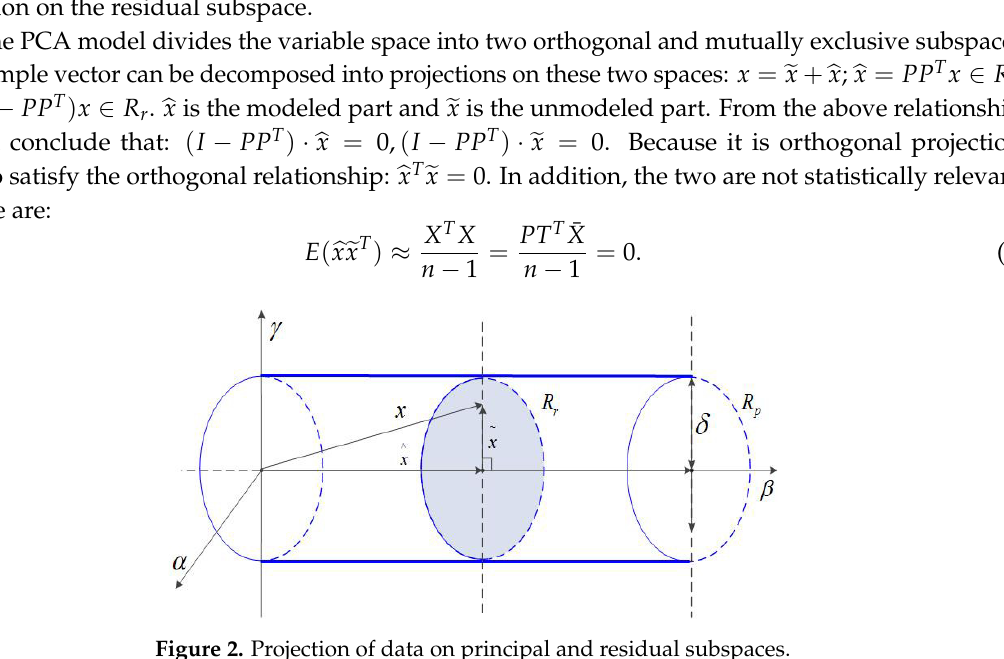
Figure 2. Projection of data on principal and residual